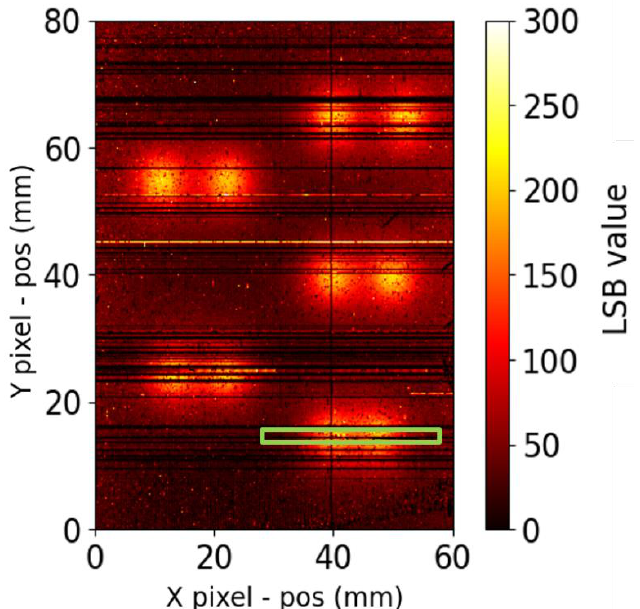
Figure 17. Heat map of the Cu mask for 40 kV X-rays. A Region of Interest (ROI, green lines) was set on the holes in 3 mm distance. The spatial resolution was estimated by fitting the profile in the ROIs by a Gaussian function.